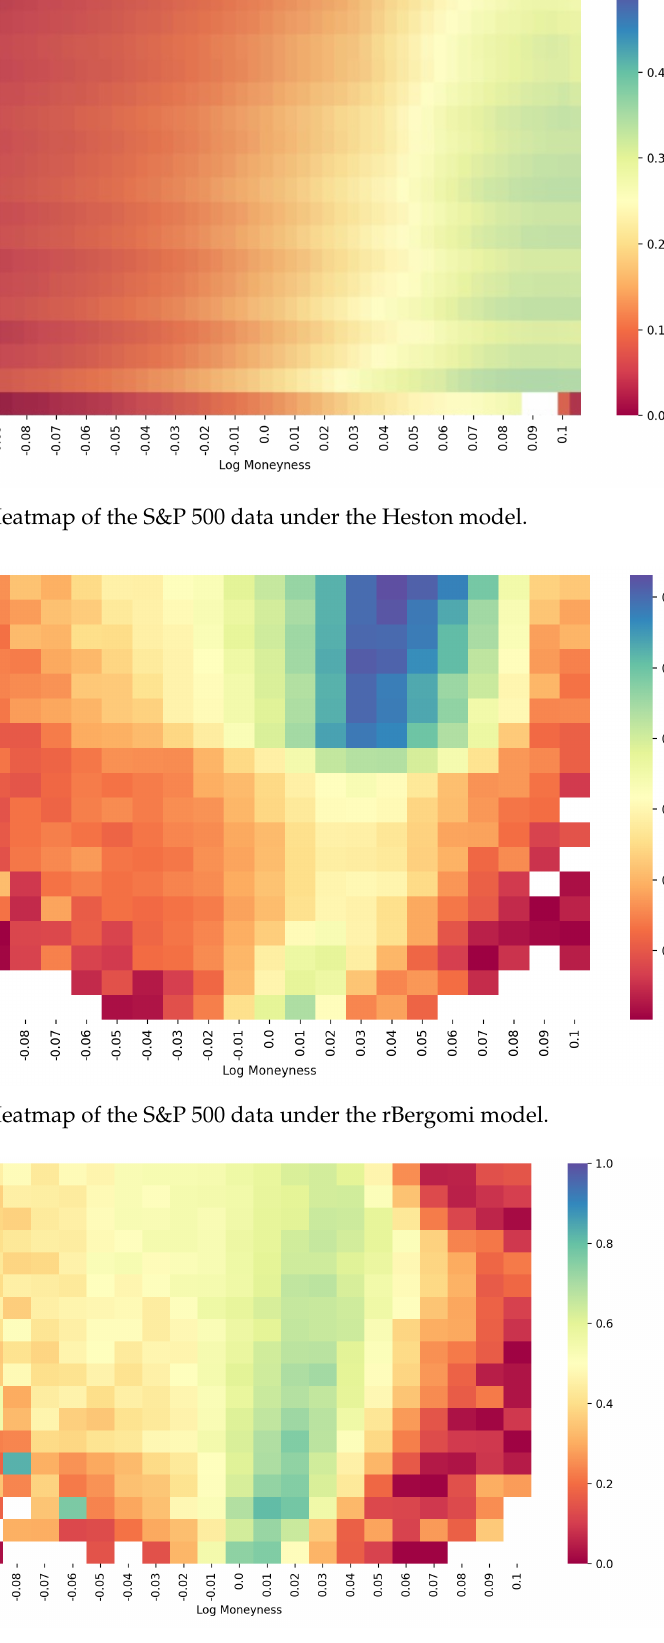
Figure 10. Heatmap of the FTSE 100 data under the rBergomi